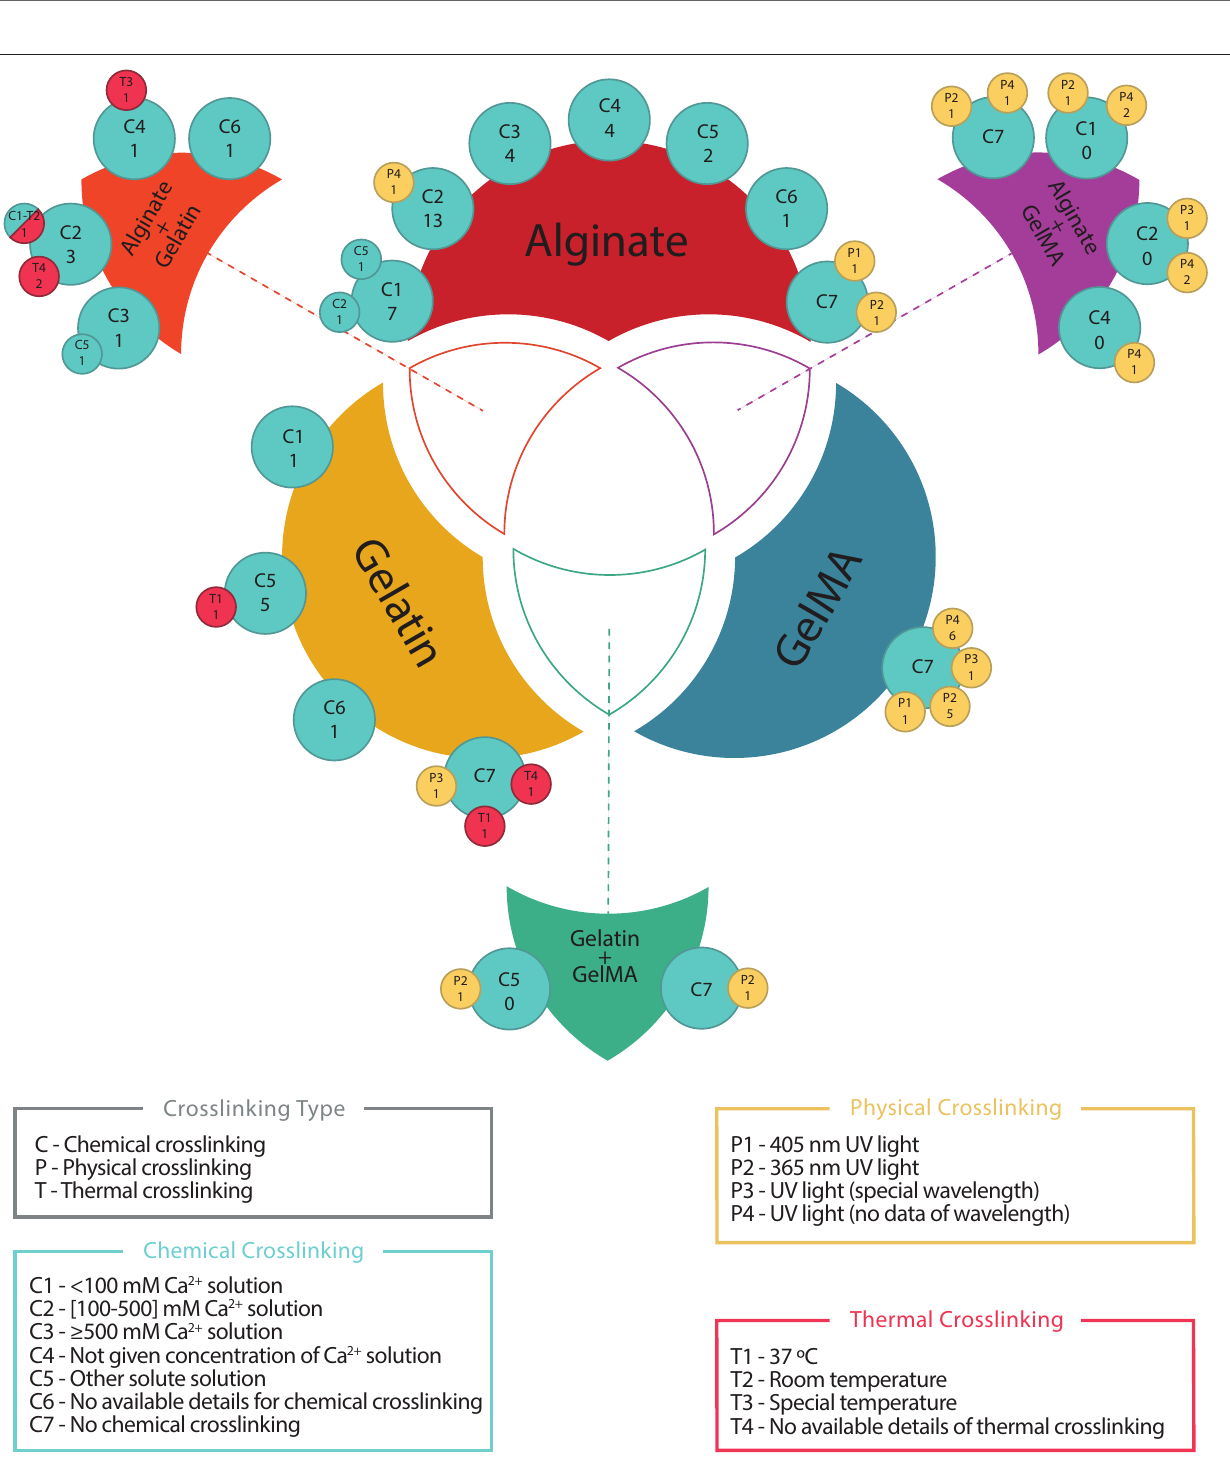
Frontiers in Bioengineering and Biotechnology |